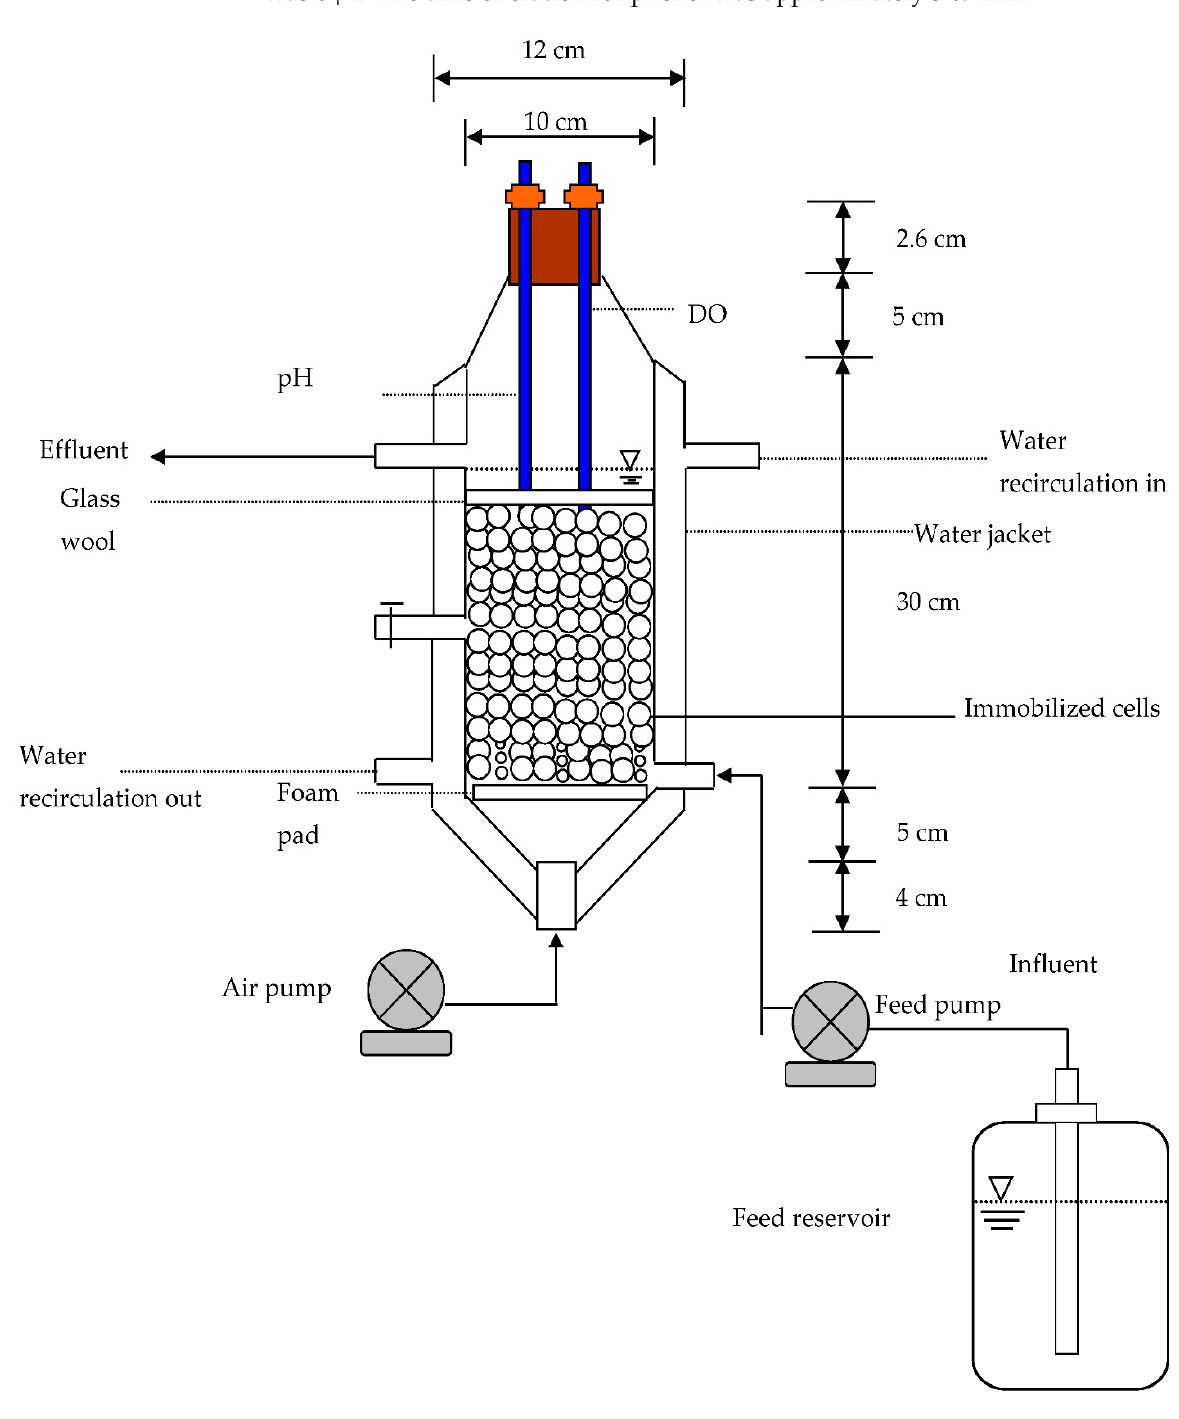
Figure 1. Schematic diagram of immobilized cells reactor setup.